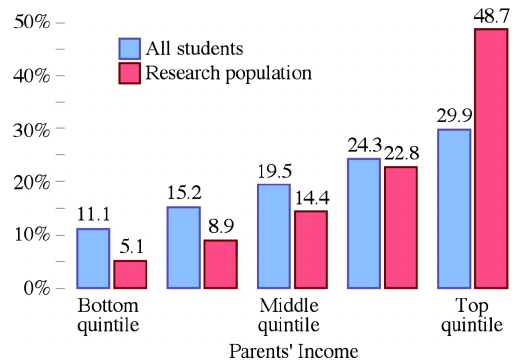
FIG. 6. Comparison of parents ’ income for research student population (from 37 universities representing 87% of the PER research population) to overall student